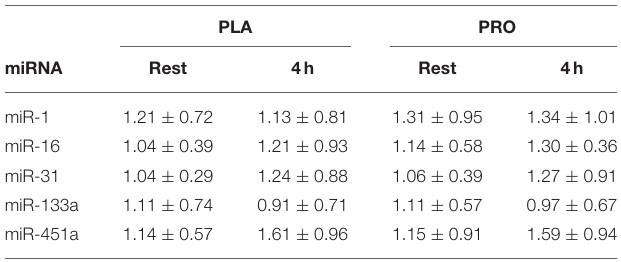
TABLE 1 | Expression of unchanged miRNAs measured at rest and 4h post-exercise in PLA and PRO conditions (Arbitrary Units; mean ±